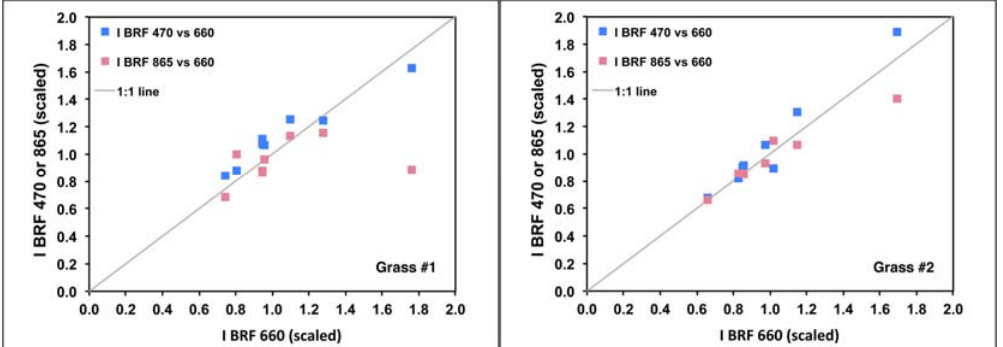
Figure 15. Intensity-domain bidirectional reflectance factors (BRFs) at 470 and 865 nm, normalized by the spectral c λ values, plotted against corresponding values at 660 nm. The various points correspond to data acquired at different times of day. The majority of points fall on the 1:1 line, indicating that the angular shape of the BRFs are spectrally neutral, with the exception of a few 865-nm values over the grass